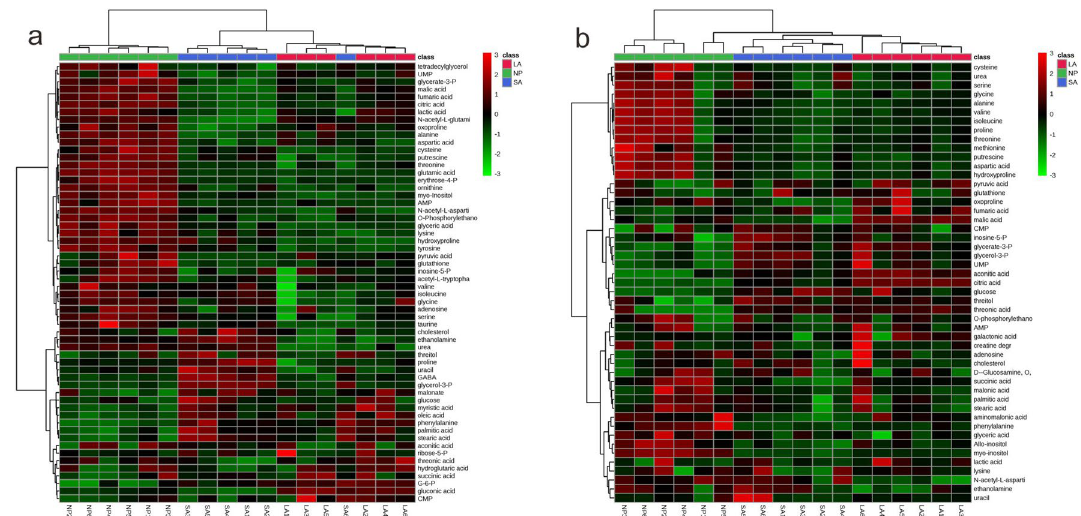
Figure 3. Heat maps of the identified metabolites in MDA-MB-231 ( a ) and MCF-7 ( b